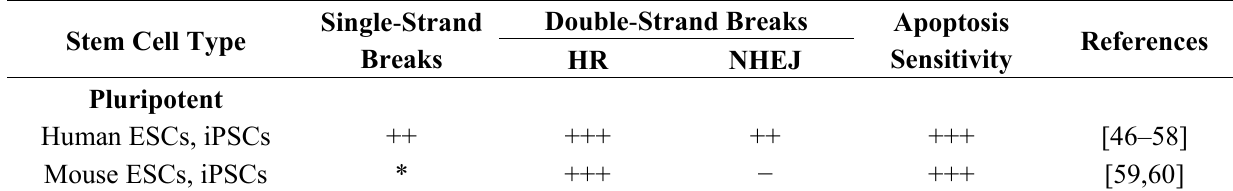
Table 1. Summary of single-strand and double-strand break repair strategies and apoptosis sensitivity in pluripotent and multipotent stem cell populations compared to differentiated somatic